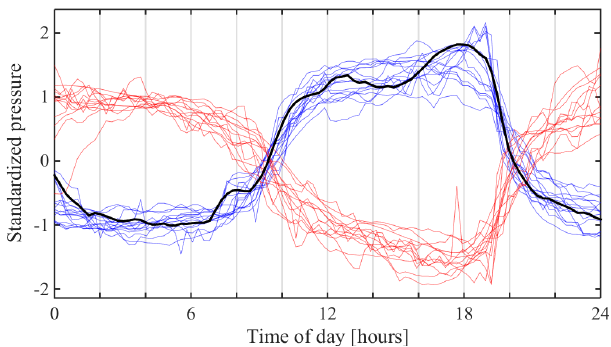
Figure 6. Best shapelet found for classification of mechanical con- nections (black line). This shapelet reached an 81% information gain (OSP = 12.9). For comparison, 23 time series of mechanical diurnal oscillations are also shown (blue and red